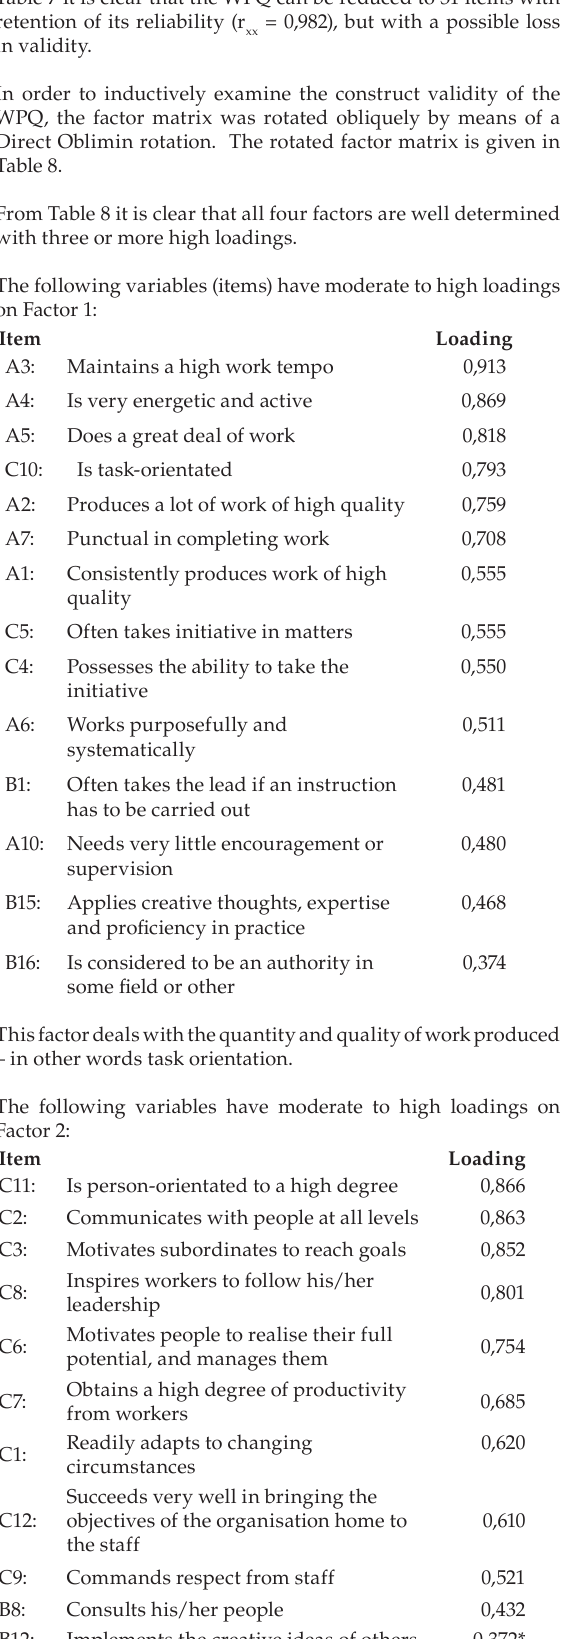
of scores [(∑r s ) 2 = s 2 ] (cf. Schepers, 1992, pp. 28–32). From g gx g Table 7 it is clear that the WPQ can be reduced to 31 items